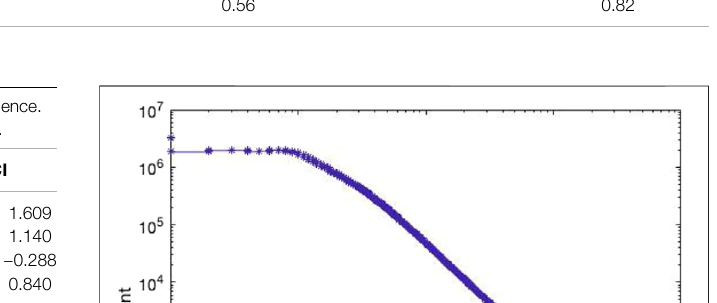
TABLE 5 | Pearson-moment correlation among citizen science variables and science indicators. The highest correlation is between the number of contributions and the number of S&T publications. R&D budget (log) # S&T publications (log) Of researchers (log) Volunteers (log) 0.75